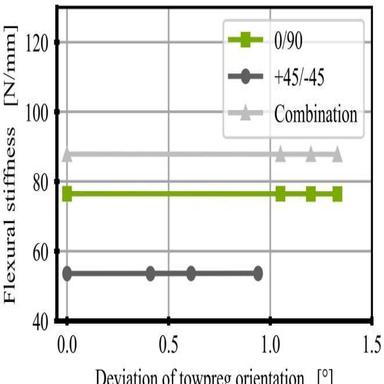
Correlation between analytically modelled flexural stiffness of 2D plate and varied towpreg orientation.